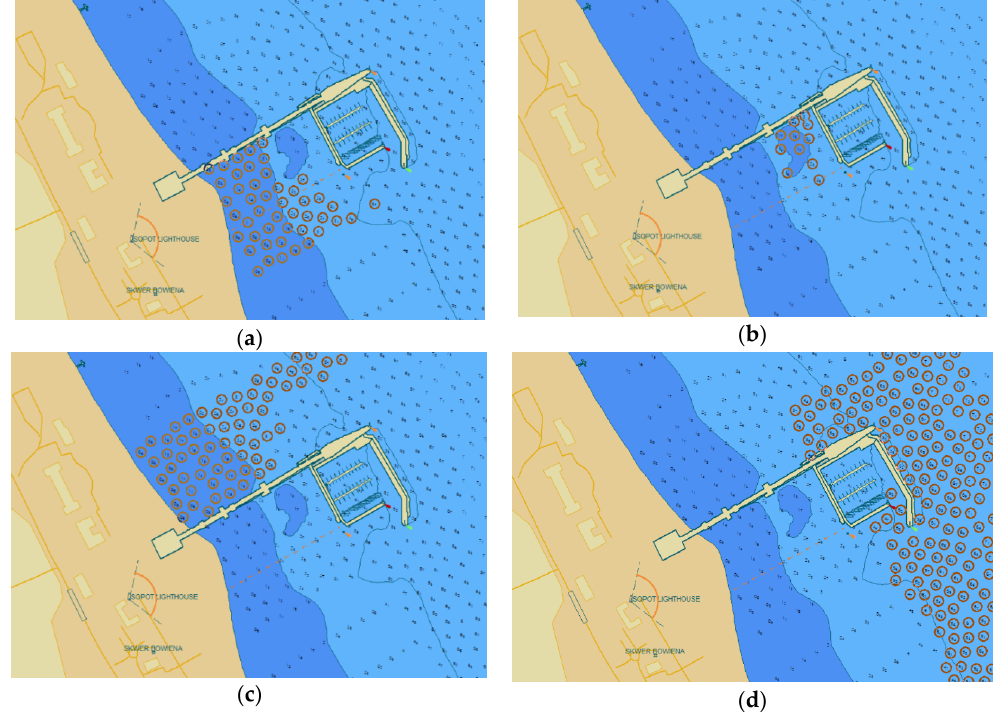
Figure 7. Data acquisition time: 28 April 2010 ( a ), 16 June 2014 ( b ) 22 June 2011 ( c ), 01 March 2017 ( d